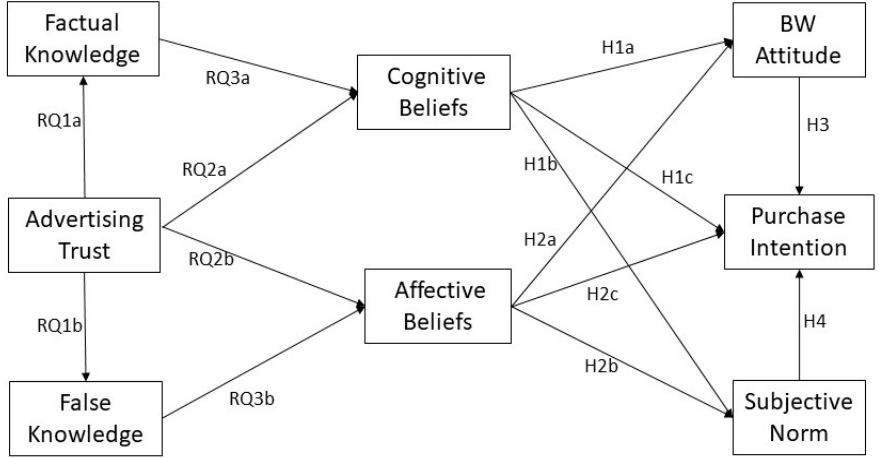
Figure 1. Proposed Advertising and Knowledge Conceptual Model.